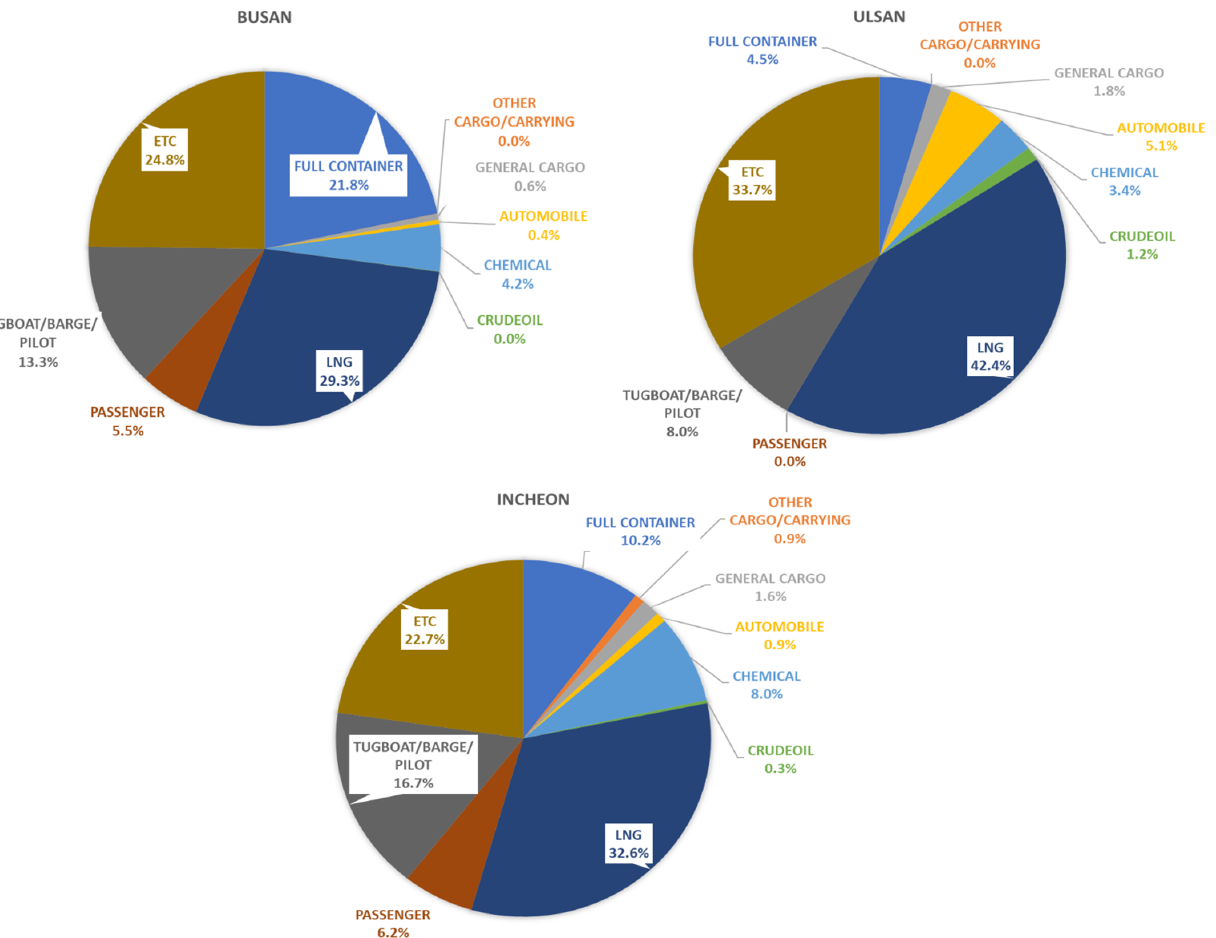
Figure 2. The portion of total ships entering and departing (by ship